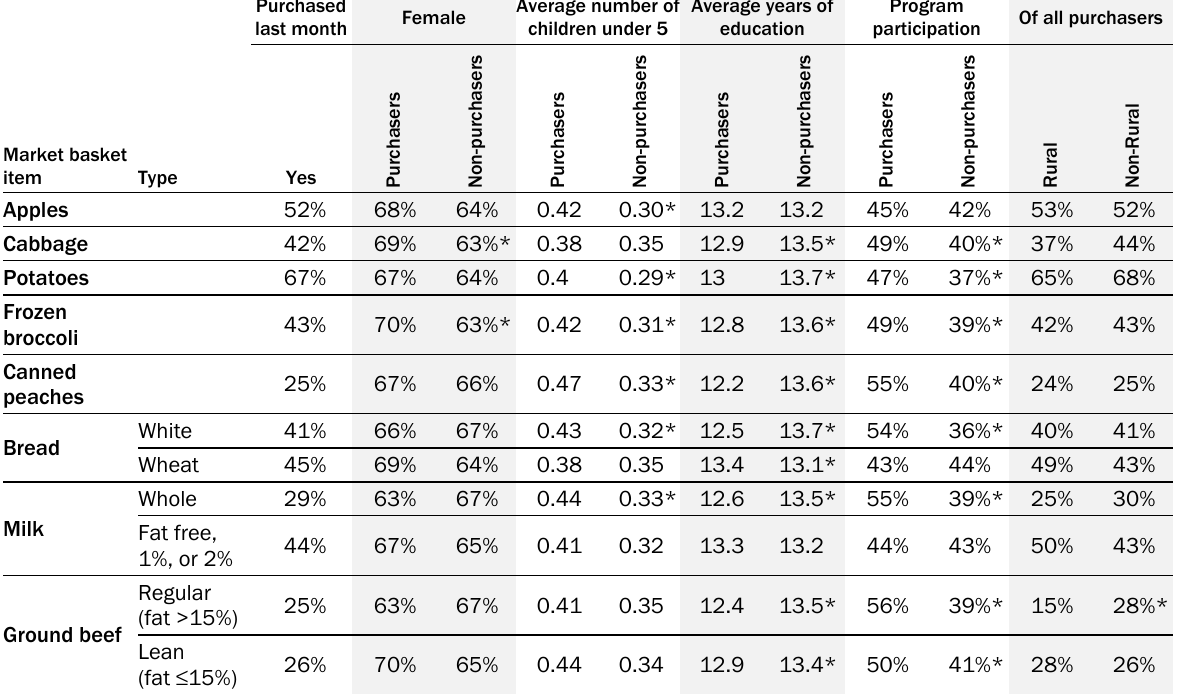
Table 4. Intercept Survey Respondents’ Characteristics with Respect to Purchasing Market Basket